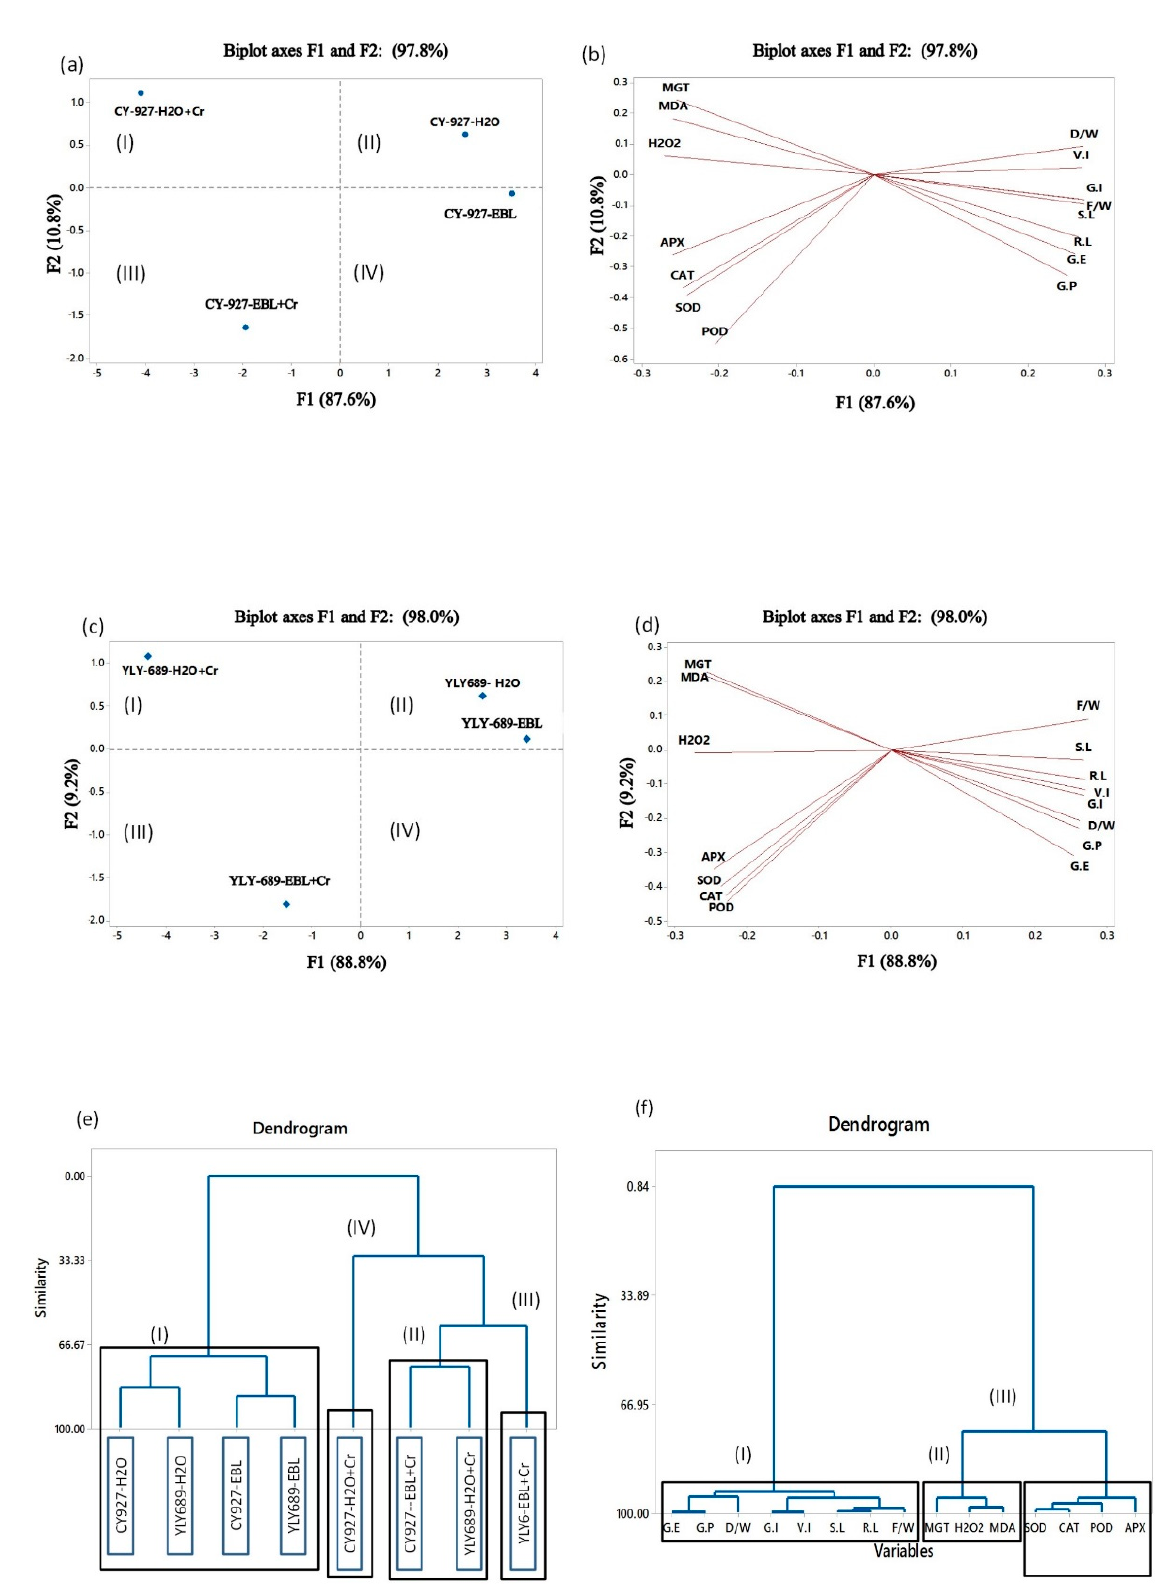
Figure 6. Bioplot of principle components 1 and 2 of the PCA extracted from the results obtained from physiological data of two various rice cultivars (CY927, YLY689) under different treatments such as control primed with water (CY927-H 2 O, YLY689-H 2 O), control primed with EBL (CY927-EBL, YLY689-EBL), seed primed with EBL, and treatment under Cr stress (CY927-EBL + Cr, YLY689-EBL + Cr), seed primed with H 2 O under Cr stress (CY92-Cr + H 2 O, YLY689-Cr + H 2 O). A sharp angle represented a positive correlation, an obtuse angle showed a negative correlation, and a right angle demonstrated a correlation between parameters. ( a ) Representation of the correlation between different treatments in rice cultivar CY927. ( b ) Physiological parameters of rice variety CY927 are represented through Pearson’s correlation coefficients under differ- ent treatments. ( c ) Illustration of correlation between various treatments in rice cultivar YLY689. ( d ) Physiological param- eters of rice variety YLY689 representation via Pearson’s correlation coefficients under various treatments. Distance be- tween each line represented the strength of the correlation. (I) contains MDA, MGT, and H 2 O 2 ; (II) shows G.I, F/W, D/W, G.E, G.P, and V.I; (III) illustrates POD, CAT, APX, and SOD; (IV) represents R.L and S.L. ( e ) Dendrogram of two different